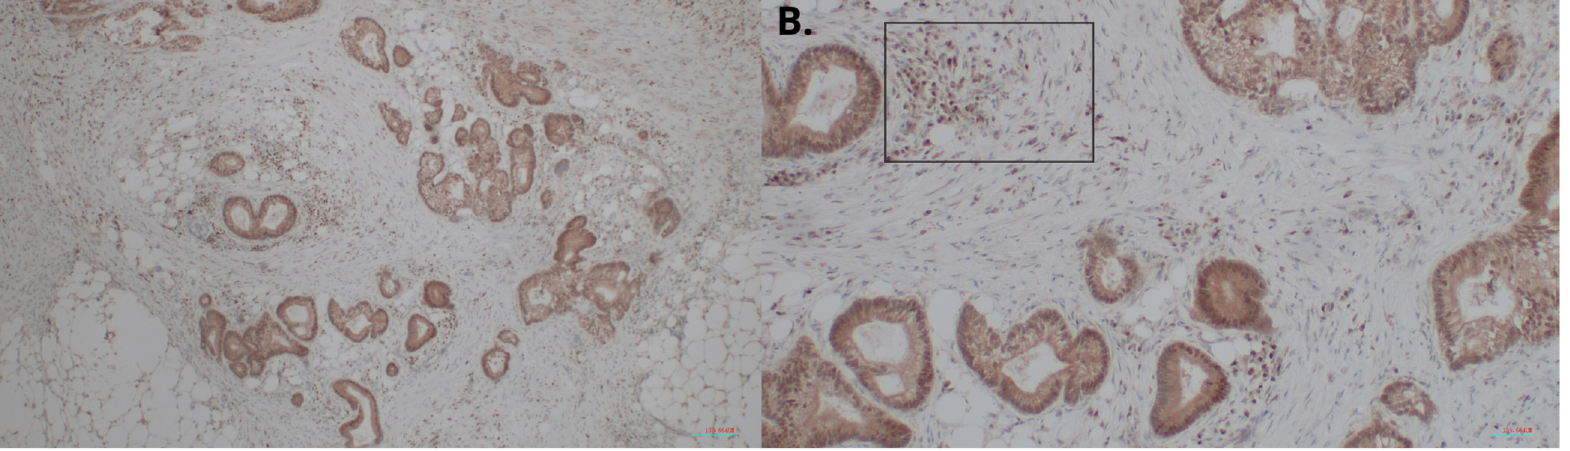
Figure 2. HHLA2 immunostaining in CRC specimens. Intense staining of the glands and accompanying infiltration of lymphocytes: ( A ) 100 × magnification; ( B )